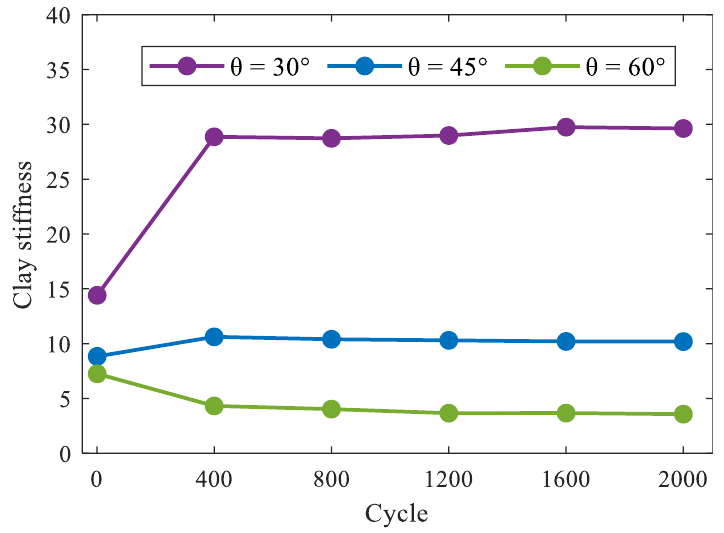
Figure 12. Variation in soil stiffness under cyclic loading with variable initial tension angles.